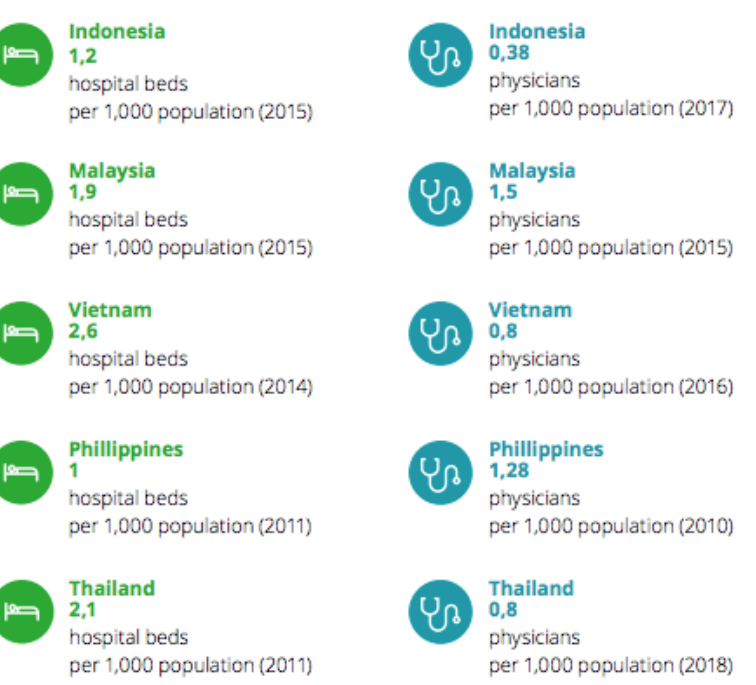
Figure 10: Ratio of hospital beds to population and Ratio of physicians to population Source: World Bank